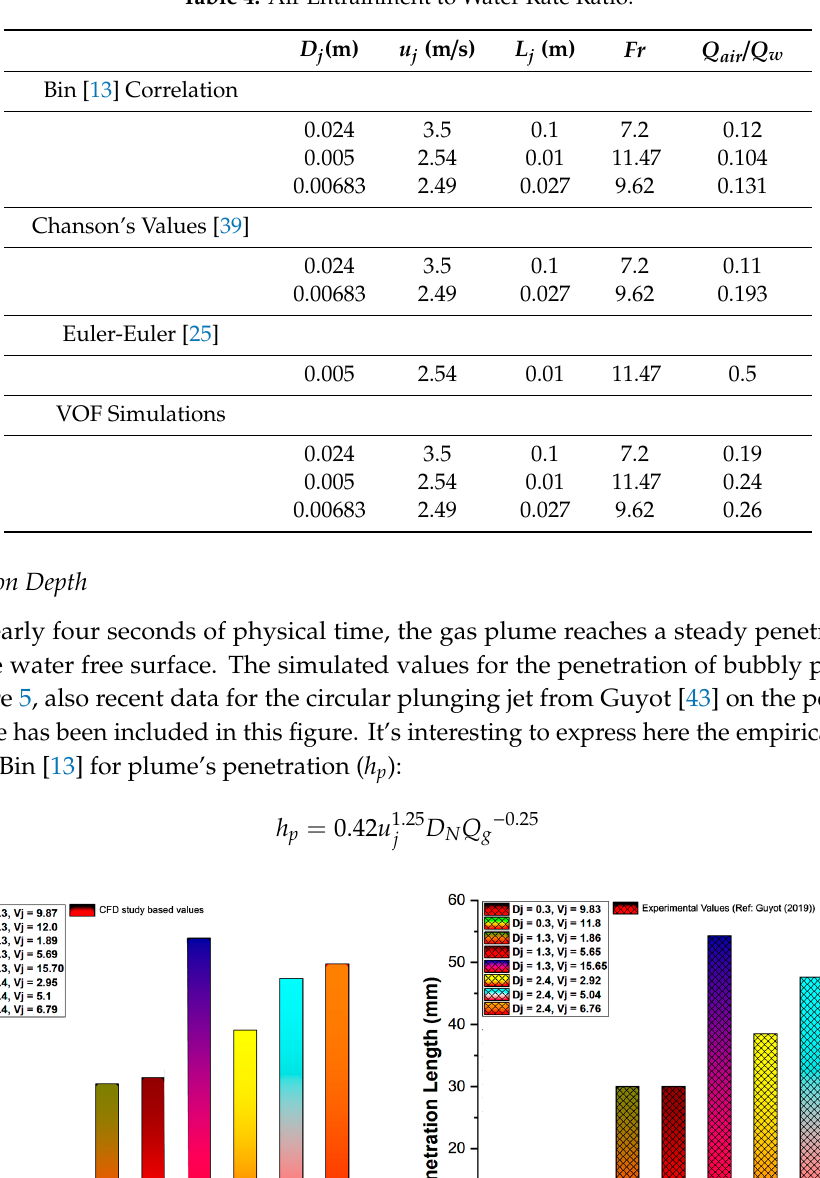
Table 4. Air Entrainment to Water Rate Ratio.